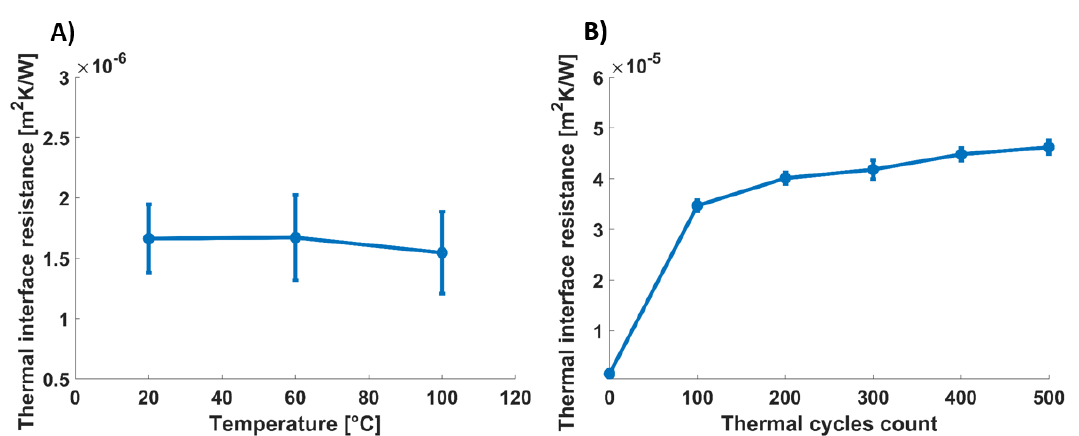
Figure 5. ( A ) Results from the initial laser flash measurement of the CNT array TIM; and ( B ) thermal interface resistance of the CNT array TIMs during thermal